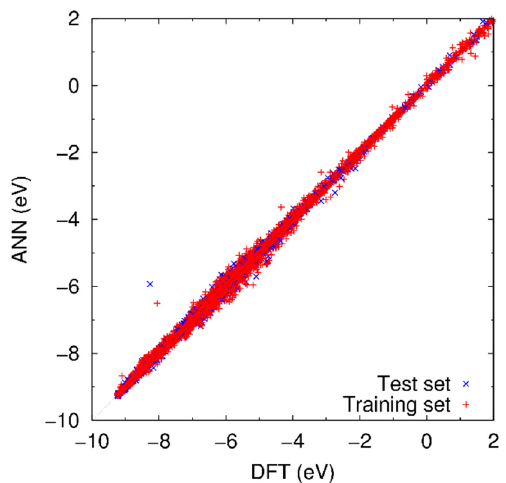
Figure 3. Potential energy of reference structures obtained by ANN potential and DFT calculation. Note that there are data points with the potential energy beyond +2.0 eV, which are not shown here because of less importance.